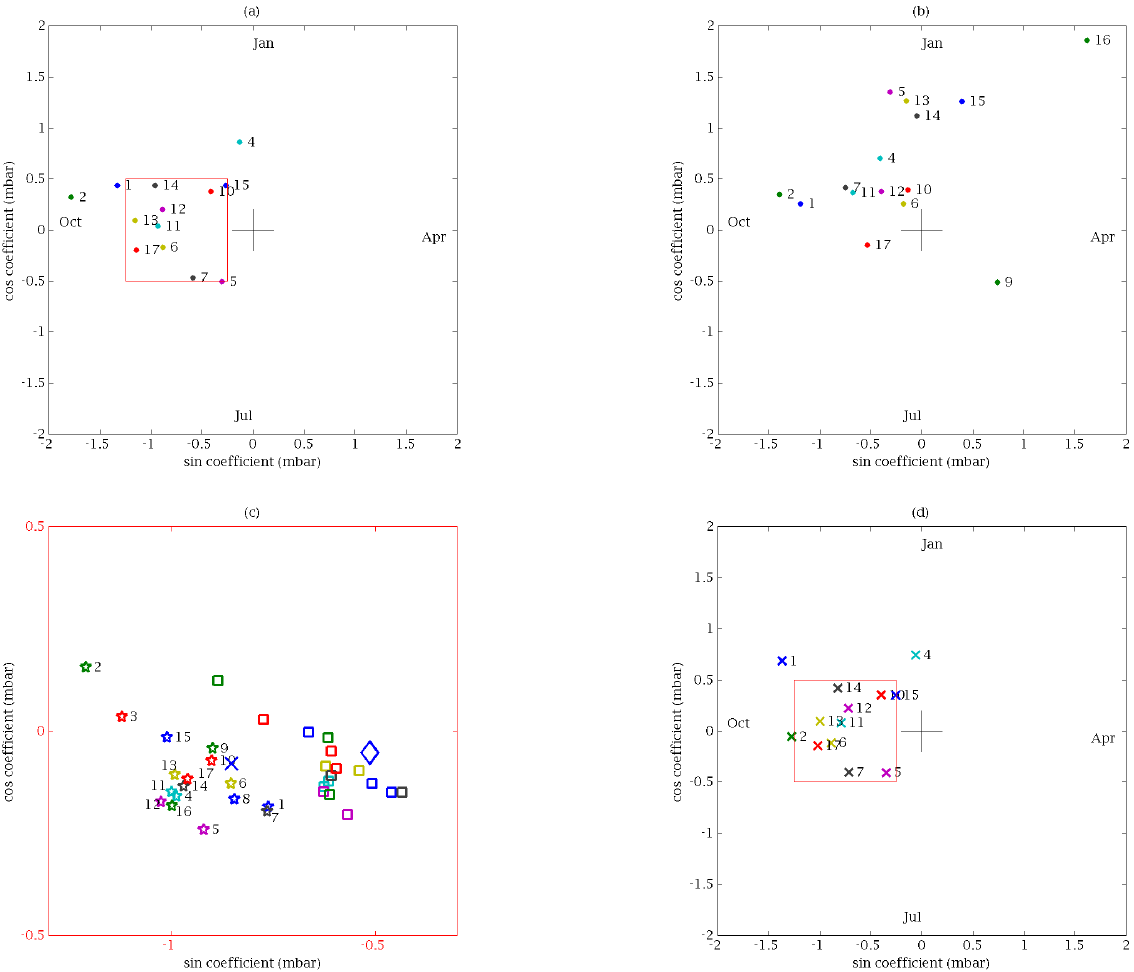
Figure 4. Phasor diagrams for annual cycles at each site, for: (a) local bottom pressure p ANN m predicted using iterative fitting; (b) local bottom pressure p ANN m predicted without iterative fitting (sites 3 and 8 are outside the axes); (c) local pressure p h and global ocean mass m h predicted by two hydrology models: GLDAS-1 is shown with stars ( p h ) and cross ( m h ), GLDAS-2.0 with squares ( p h ) and diamond ( m h ); (d) global ocean mass m o , using a hydrology model GLDAS-1 to provide F s . Axes for (c) are indicated by red box on (a) . All converged sites are included, some have large error bounds to be described